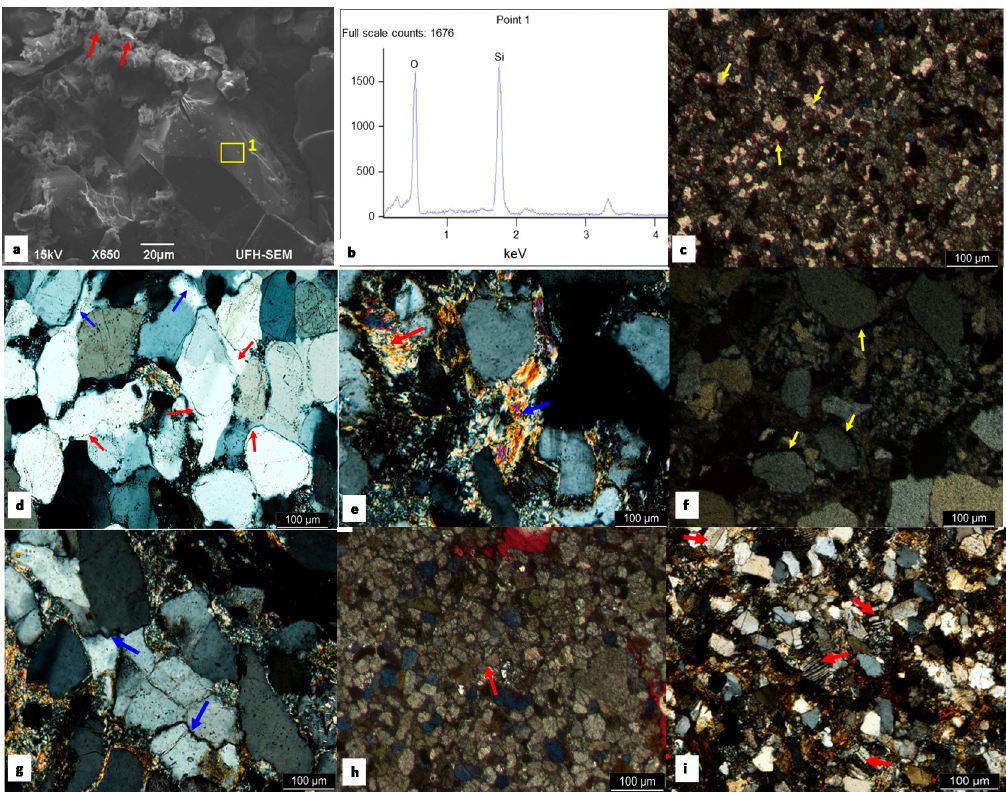
Figure 5. ( a ) SEM image of pore-filling rosette-like chlorite (red arrow) and euhedral quartz in sandstone from Borehole E-D3; ( b ) EDX spectrum showing elemental composition of quartz at point 1 in Figure 4m; ( c ) Photomicrograph of sandstone from borehole E-BB1 showing ferroan calcite (yellow arrows) filling intergranular pores; ( d ) Photomicrograph of sandstone from Borehole E-D3 showing authigenic quartz cement (blue arrows) and quartz overgrowths (red arrows); ( e ) Photomicrograph of sandstone from borehole E-BB1 showing Recrystallization of kaolinite and smectite to illite (red arrow) and muscovite (blue arrow); ( f ) Photomicrograph showing authigenic pyrite cement in the form of thin rim or patch surrounding framework grains (yellow arrows); ( g ) Photomicrograph of sandstone from borehole E-BA1 showing Dissolution cracks (blue arrows) formed by pressure dissolution along grain boundaries; ( h ) Photomicrograph of sandstone from Borehole E-BA1 showing clay matrix with chlorite component (brownish colour) and ferroan calcite (reddish colour); ( i ) Photomicrograph of sandstone from Borehole E-BA1 showing partial replacement of microcline by albite (red arrows).